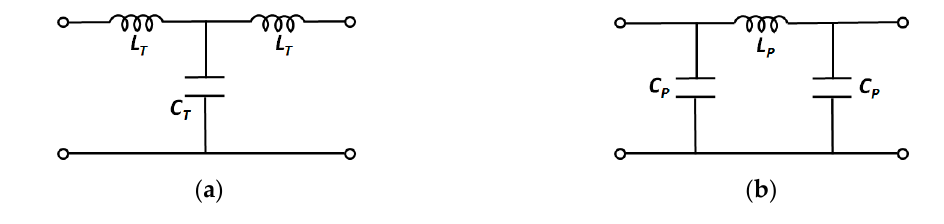
Figure 5. Impedance matching networks for cables (a) T-type and (b) П -type [95].